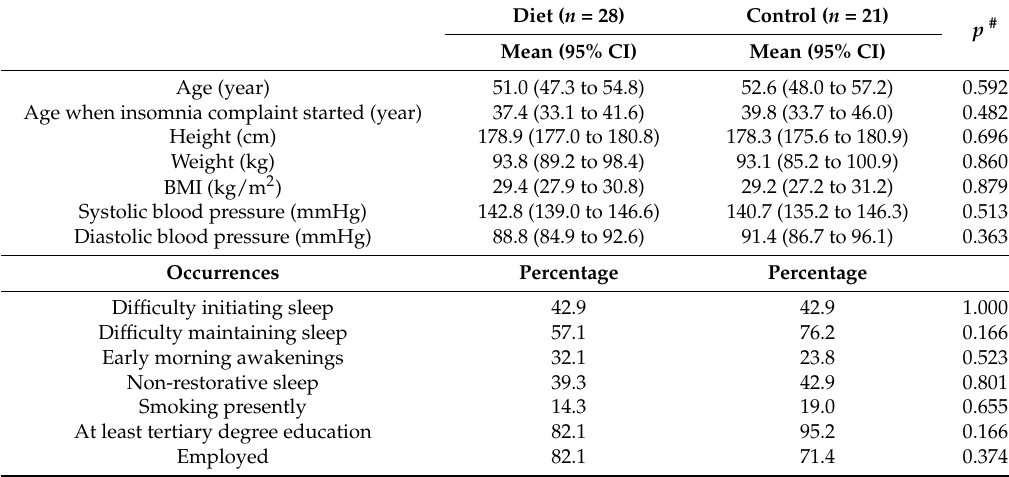
Table 1. Descriptive characteristics at